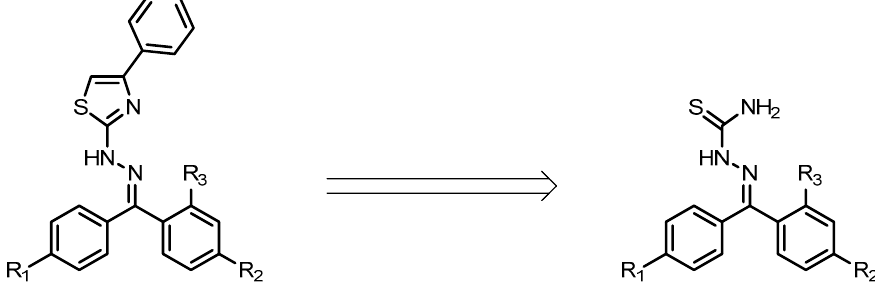
Figure 4. Retrosynthetic analysis of planned thiazole derivatives. Table 2. Docking results of thiosemicarbazones 2a – 2j in COX-1 and COX-2 active sites.